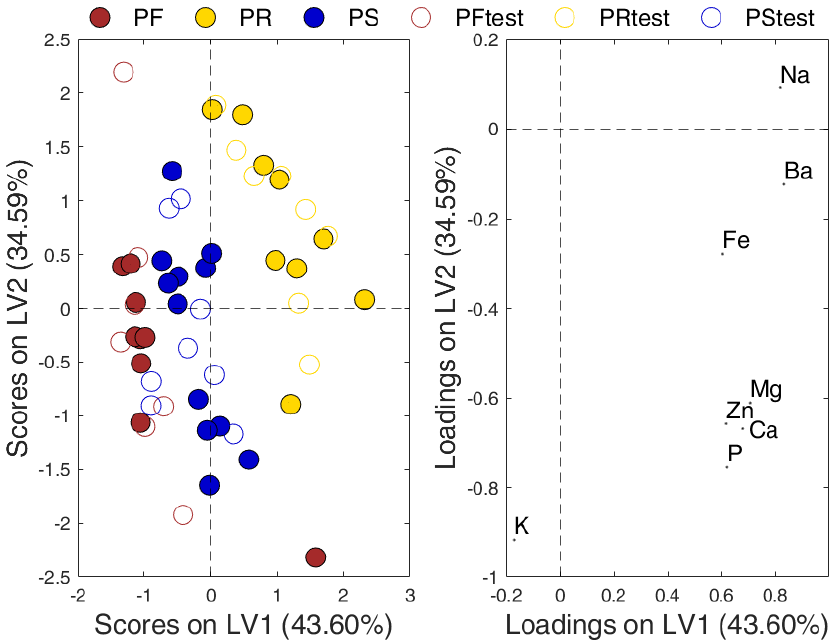
Figure 3. Projection of Pecorino samples ( left ) and variable loadings ( right ) on the first two latent variables (LV1 and LV2). Full and open circles identify the training and the test samples, respectively.